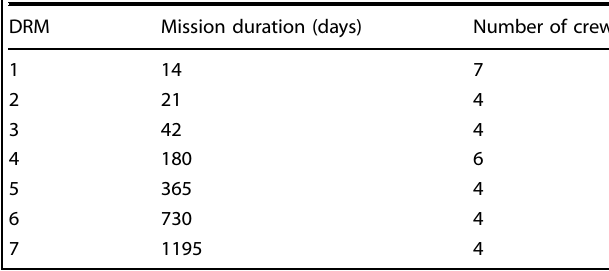
Table 1. Design reference mission